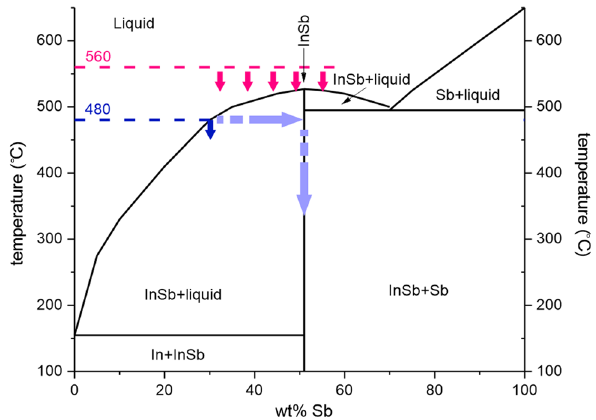
Fig. 5 Phase diagram for In-Sb system with the two possible process paths for InSb solidi- fication. Blue arrows indicate the low-temperature process leading to direct InSb nuclea- tion. Light blue arrows depict continued saturation until stoichiometric composition, consuming all In. Pink